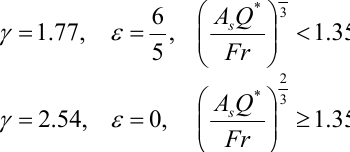
Figure 7 also shows the double-dashed chained line representing Eq. (4). The constant in the equation ranges from 0.2 to 0.4. Here, we used 0.3 as the constant C C k The parameters γ and ε are decided by the parameter ( A